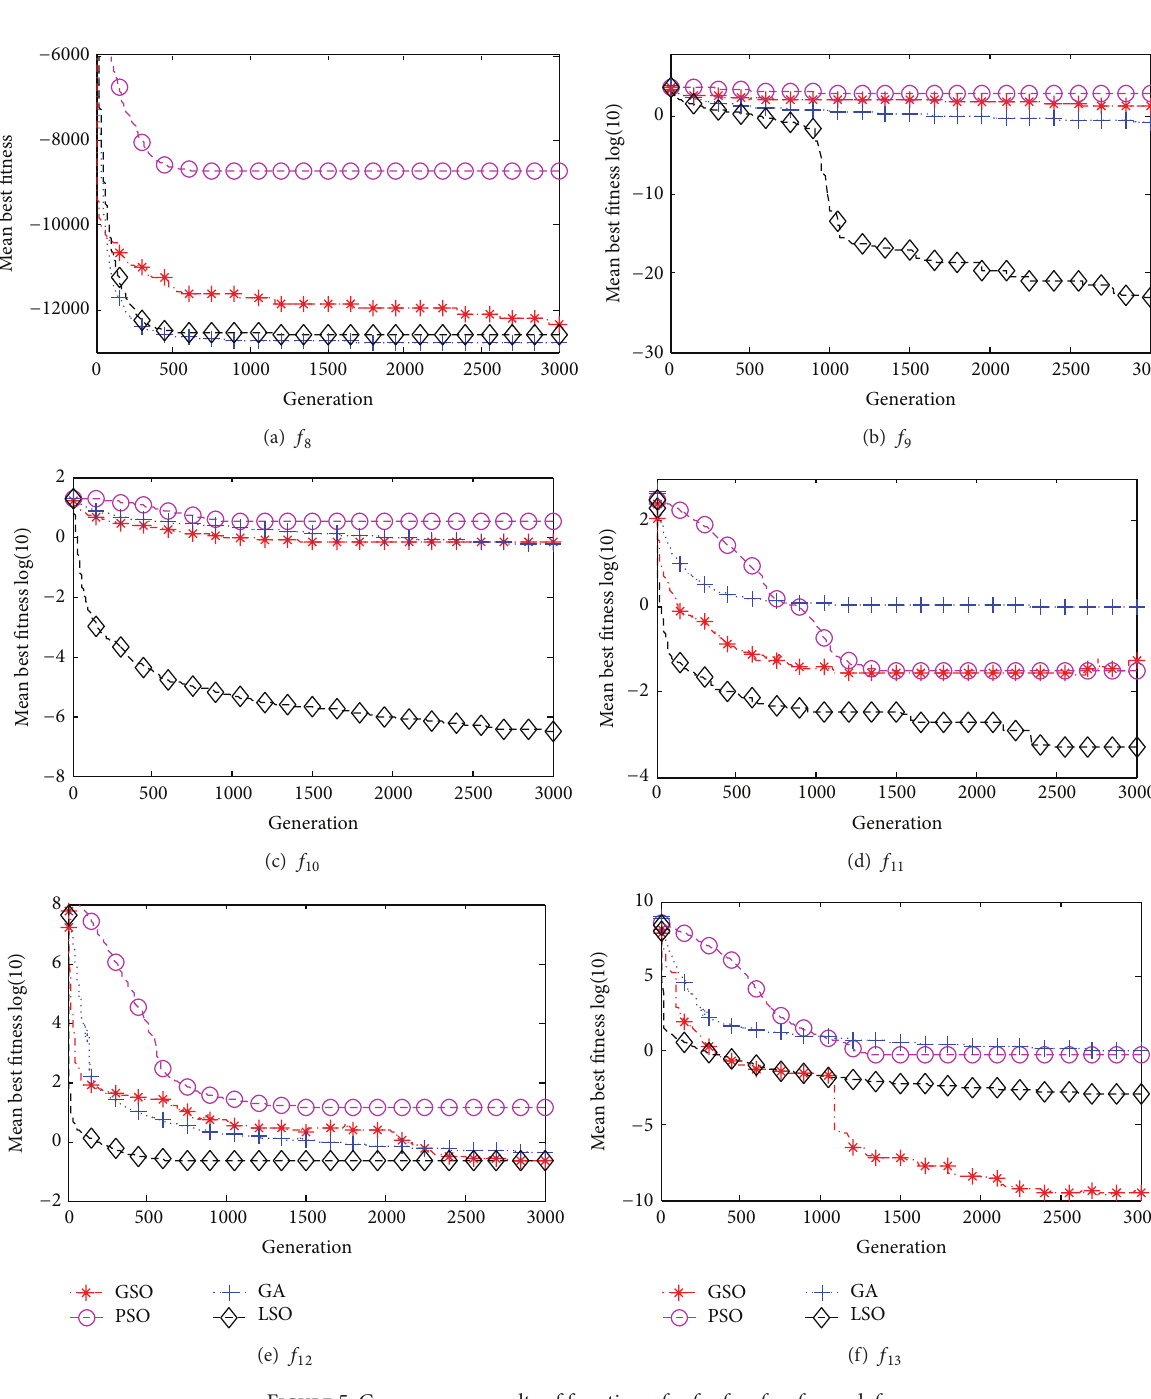
Figure 5: Convergence results of functions 𝑓 8 , 𝑓 9 , 𝑓 10 , 𝑓 11 , 𝑓 12 , and 𝑓 13